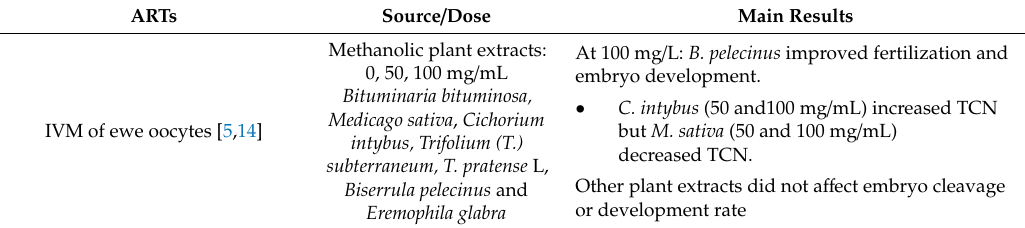
Table 5. Summary of recent in vitro studies on e ff ects of polyphenols on outputs of some assisted reproductive techniques (ARTs) in female farm